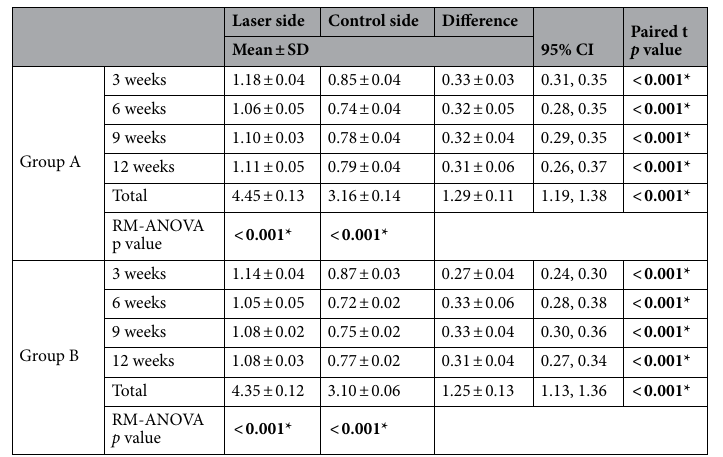
Table 3. Comparison of canine retraction (mm) between the laser and control sides at different time points, in the two study groups. SD Standard deviation, CI Confidence interval, RM‑ANOVA Repeated measures ANOVA. *statistically significant at p value < 0.05.